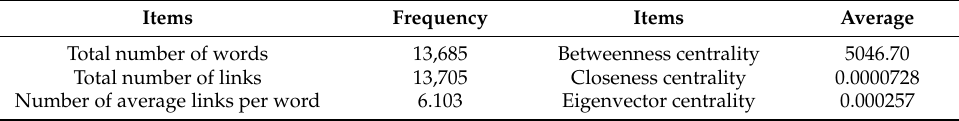
Table 2. Indices for the analysis results of the language network of survivors. Items